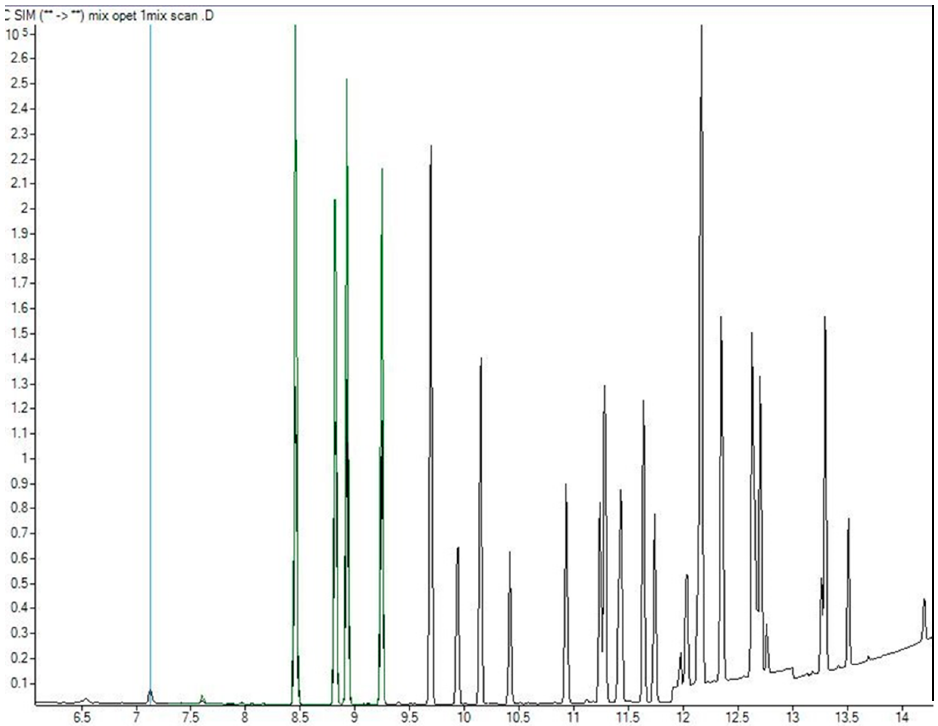
Figure 1. Chromatogram of the standard mixture.